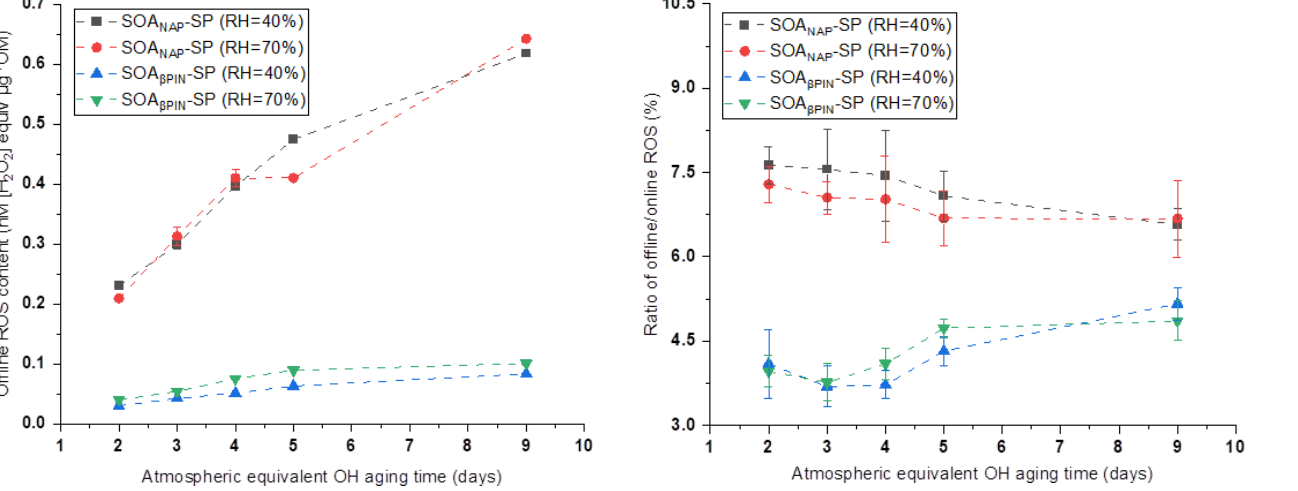
Figure 4. ROS concentrations in SOA particles quantified offline from filter samples as a function of aging time. A similar effect of photochemical aging and relative humidity (RH) on the offline (i.e., long-lived, stable) ROS content in both aerosol types was observed as for the online ROS content (see Figs. 2 and 5).